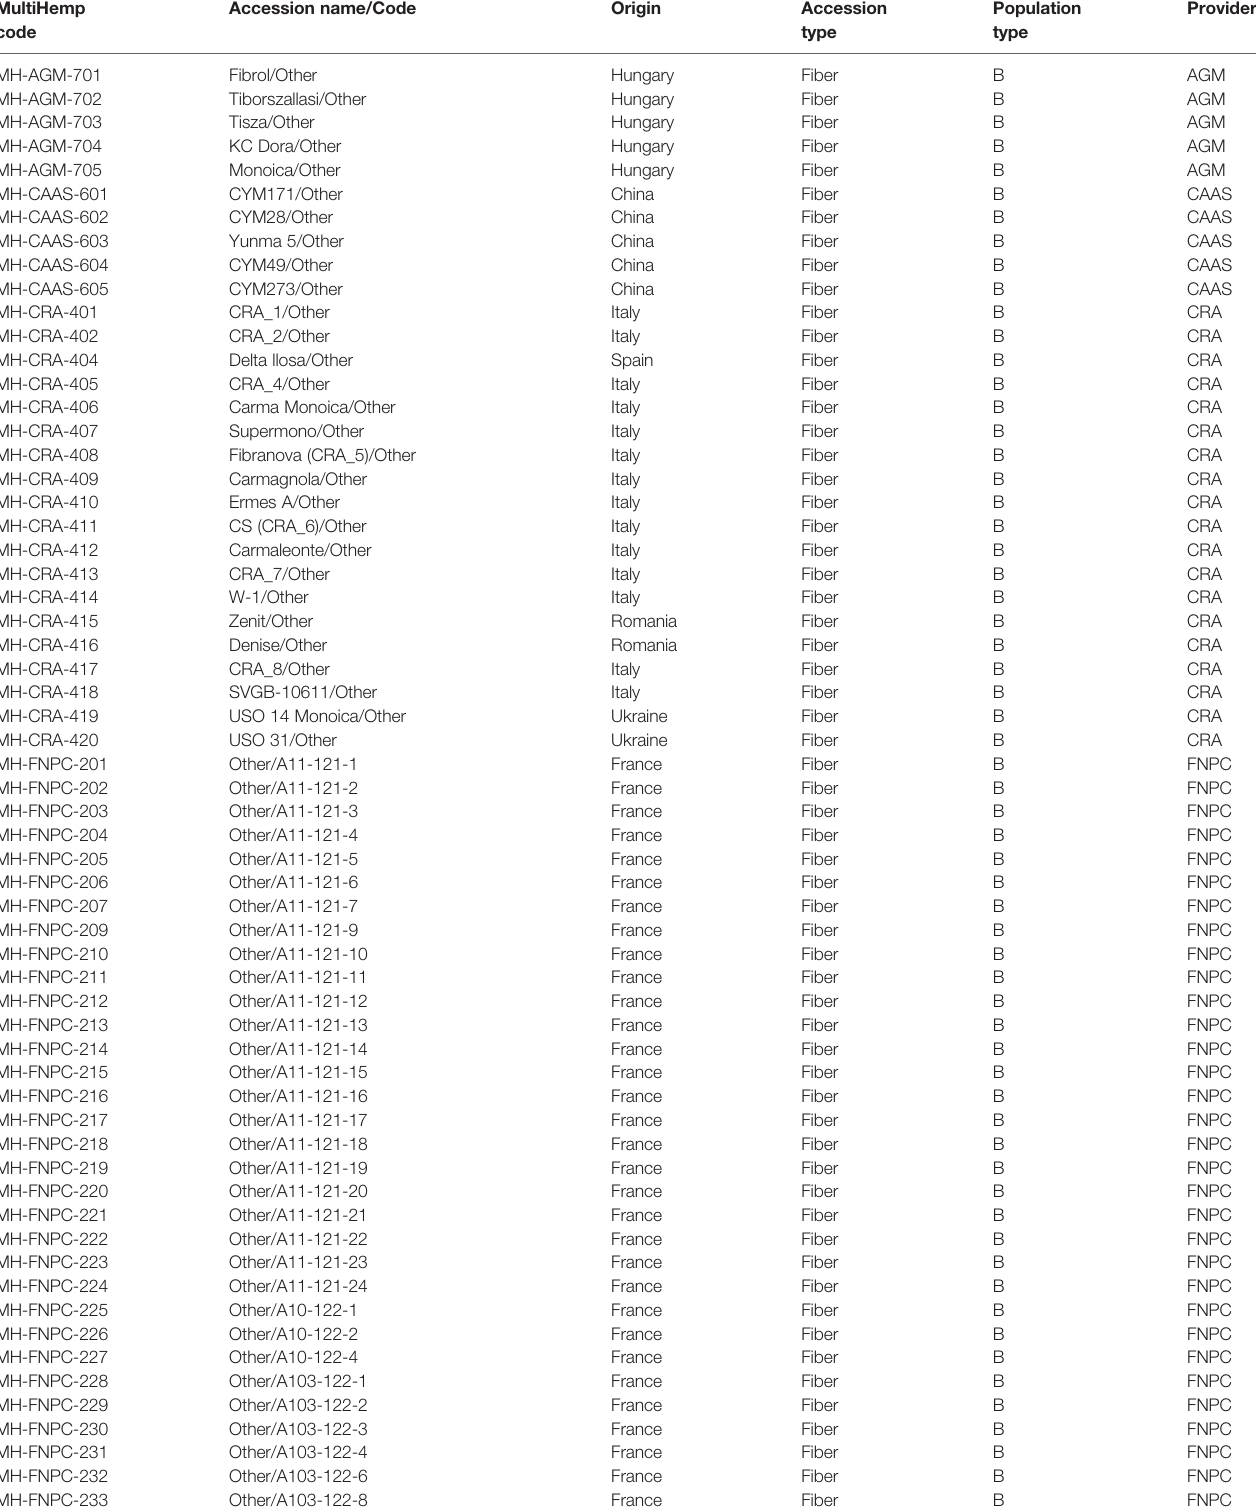
TABLE 1 | Panel of 123 hemp ( Cannabis sativa L.)